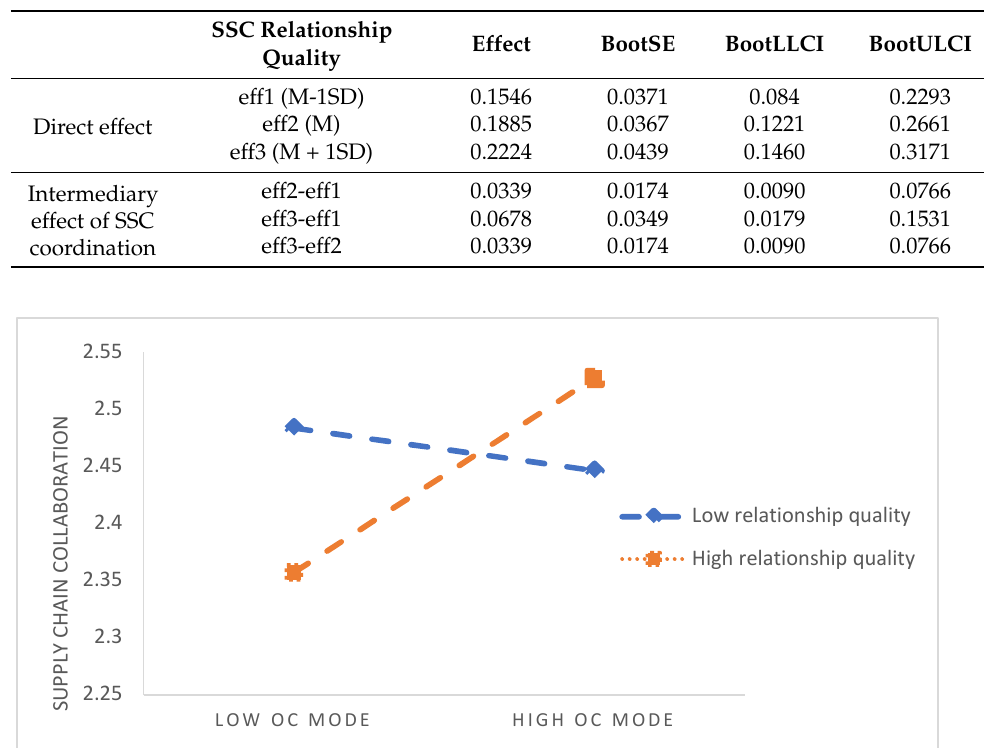
Figure 2. The regulating role of SC relationship quality between OC model and SC collaboration.